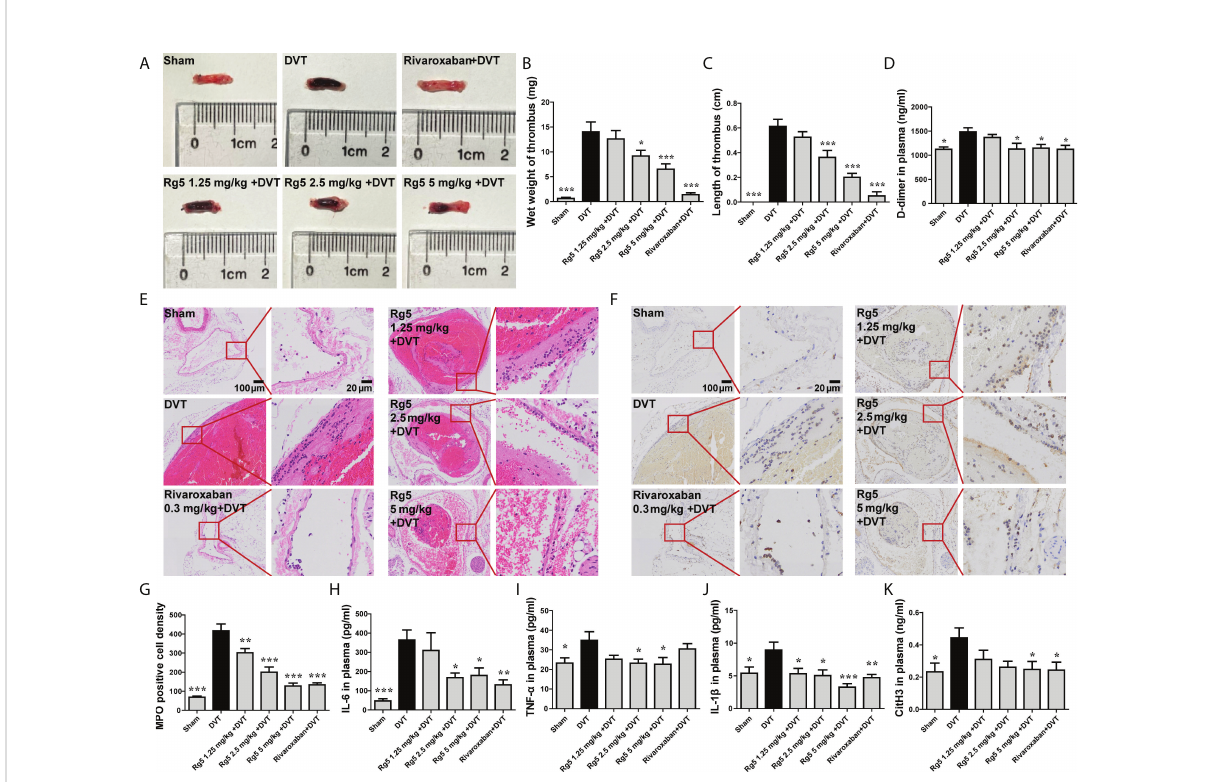
FIGURE 4 Effect of Rg5 administration on thrombosis and in fl ammation in DVT mice. (A) Morphology of venous thrombosis. (B, C) Thrombus wet weight and length (n = 8). (D) Plasma D-dimer content (n = 7). (E) HE staining of inferior vena cava. (F) MPO immunohistochemical staining of inferior vena cava. (G) MPO positive cell density (n = 6). (H – K) Plasma contents of IL-6, IL-1 b , TNF- a , and CitH3 (n = 7). Data are shown as the mean ± SEM. * P < 0.05, ** P < 0.01, *** P < 0.001 vs. DVT